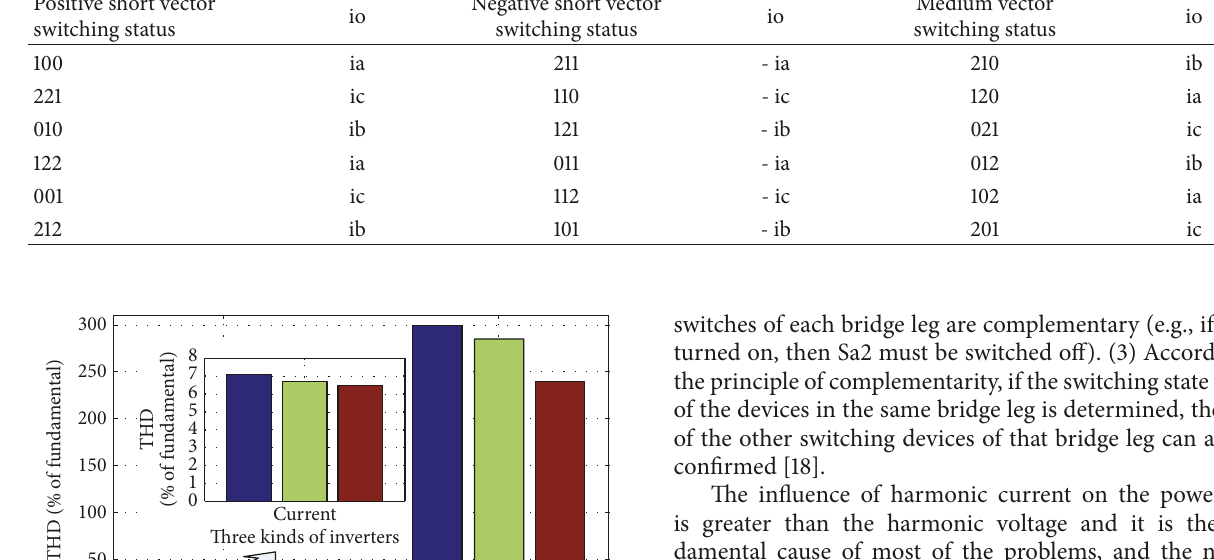
Table 7: The classification of the influence of the switching state of the short and medium vectors on the direction of the neutral point current. Positive short vector